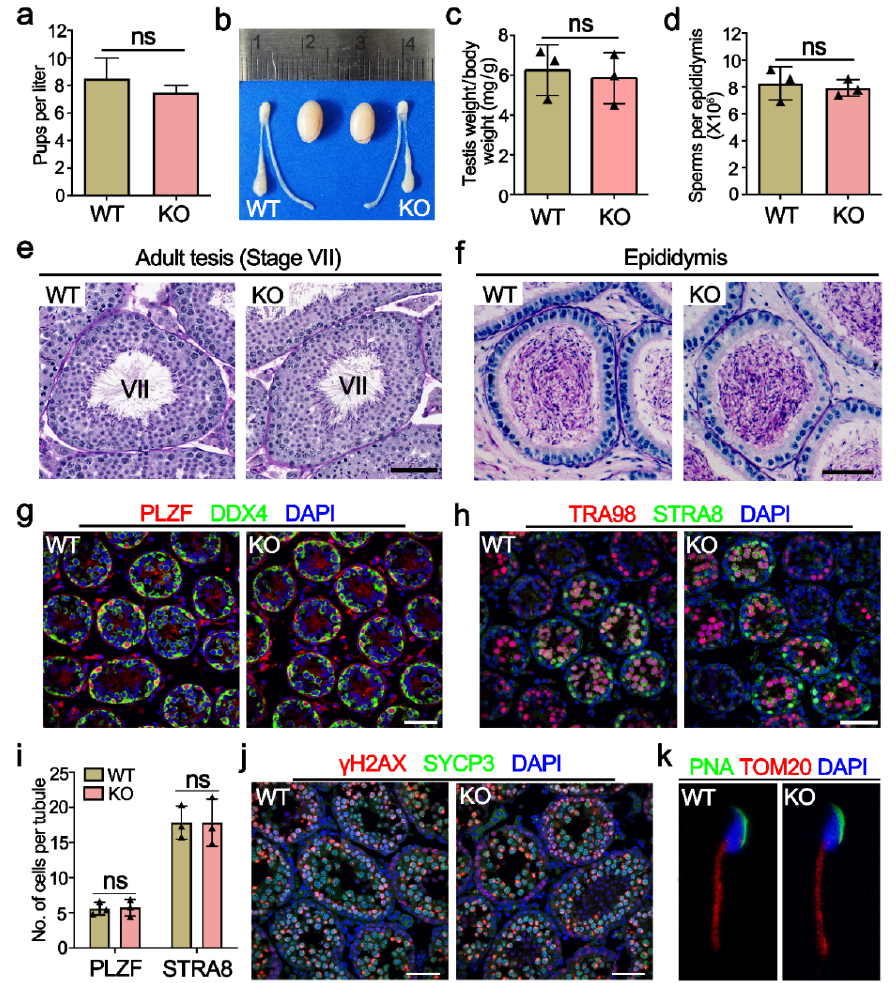
Figure 3. METTL21A is dispensable for spermatogenesis in mice. ( a ) The number of pups per litter derived from WT and KO males at the ages of 6–12 weeks. Data are presented as mean ± SEM, n = 8. ns, not significant. ( b ) The gross morphology of the testes from P56 WT and KO mice. ( c ) The ratio of testis weight to the body weight of 8-week-old WT and KO mice. Data are presented as mean ± SEM, n = 3. ns, not significant. ( d ) The sperm concentration of 8-week-old WT and KO mice. Data are presented as mean ± SEM, n = 3. ns, not significant. ( e , f ) Periodic acid-Schiff (PAS) staining of testes ( e ) and cauda epididymides ( f ) paraffin sections from 8-week-old WT and KO mice. Scale bar = 50 µ m. ( g ) Co-immunofluorescence staining of PLZF and DDX4 in P10 WT and KO mouse testes. Scale bar = 50 µ m. ( h ) Co-immunofluorescence staining of TRA98 and STRA8 in P10 WT and KO mouse testes. Scale bar = 50 µ m. ( i ) The quantification of PLZF + and STRA8 + cells per tubule at P10 in WT and KO testes, respectively. Data are presented as mean ± SEM, n = 3. ns, not significant. ( j ) Co-immunofluorescence staining of γ H2AX and SYCP3 in P21 WT and KO testes. Scale bars = 50 µ m. ( k ) Co-immunofluorescence staining of PNA and TOMM20 in spermatozoon from P56 WT and KO cauda